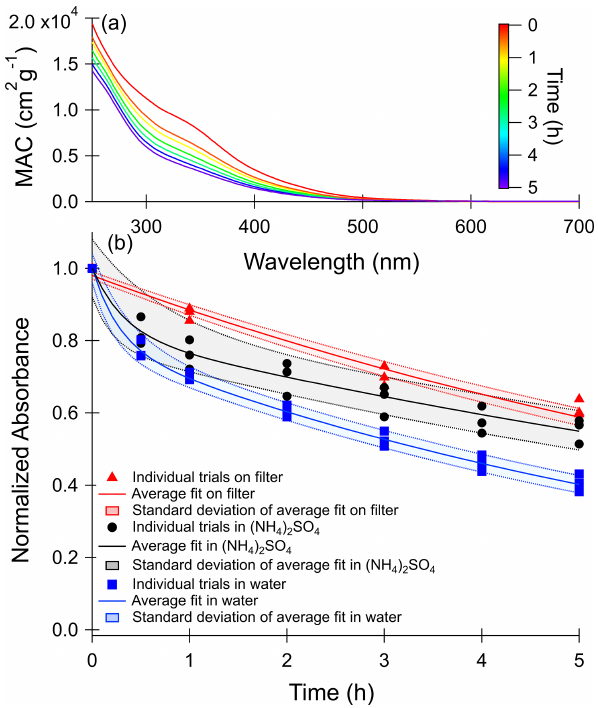
Figure 1. (a) Wavelength-dependent mass absorption coefficient (MAC) values recorded during photolysis of toluene SOA in water. MAC plots for other conditions, shown in Fig. S4, are qualitatively similar. (b) Normalized absorbance decay of the wavelengths inte- grated from 300 to 700nm with photolysis. Photolysis experiments in 1M ammonium sulfate are shown in black circles, those in pure water are shown in blue squares, and those on the filter are shown in red triangles. Values on the y axis were corrected for changes in the dark and then normalized to the mass absorption coefficient at zero minutes. Shaded areas represent 1 standard deviation of the fit of the three combined trials.